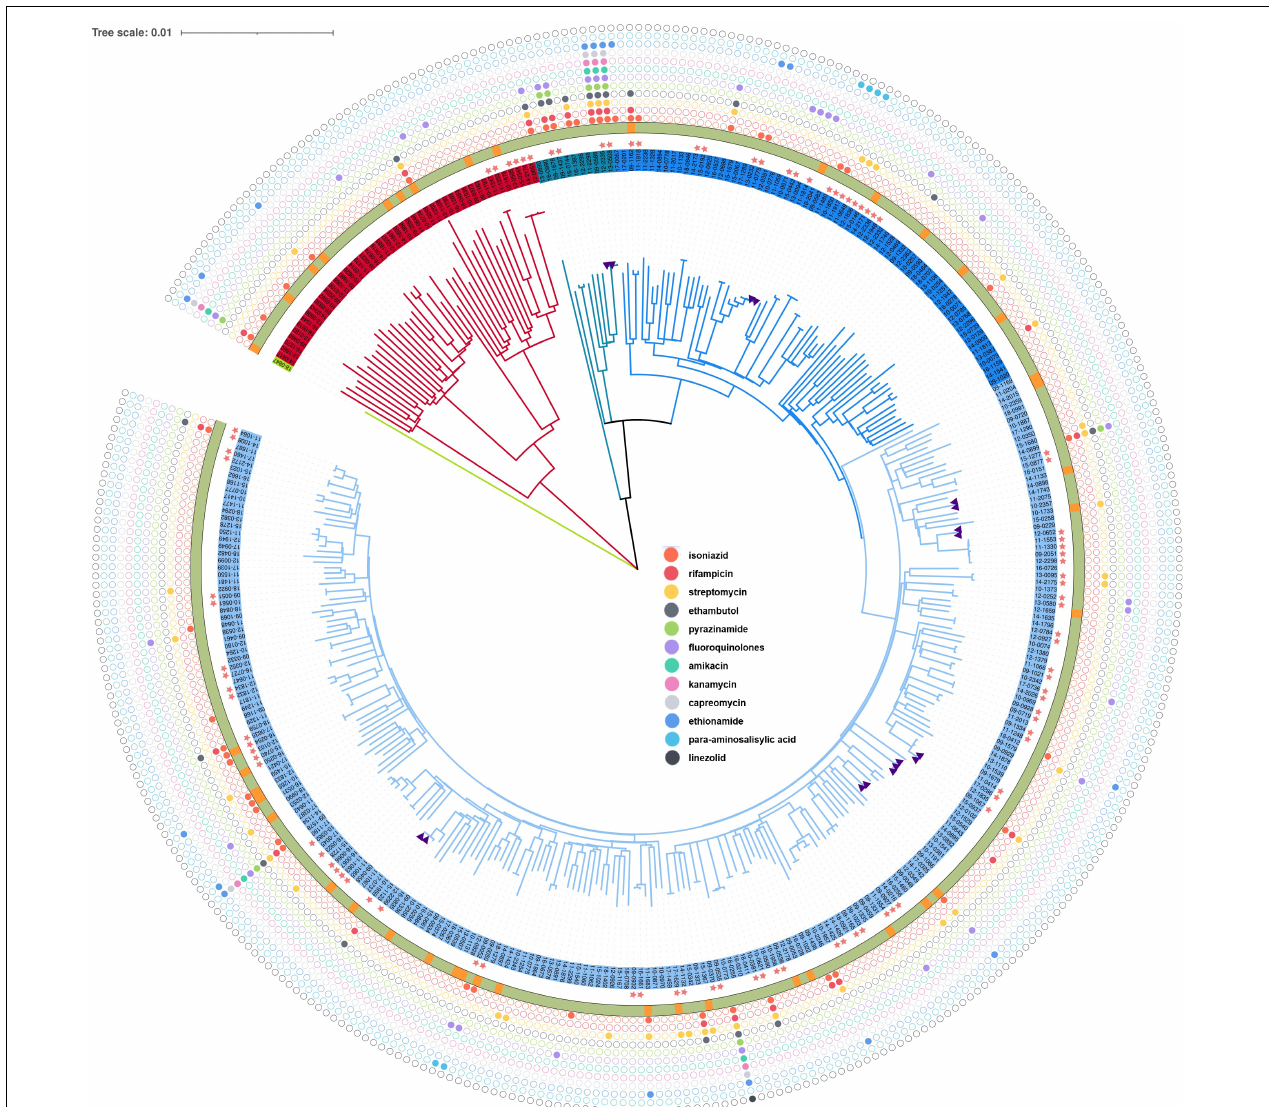
FIGURE 2 | Phylogenetic tree for the 354 Mycobacterium tuberculosis isolates from Shanghai, China, 2009–2018. The purple triangles represent isolates from relapsed cases ( n = 9). The pink five-pointed stars indicate the clustered isolates, whose genetic distance is ≤ 12 single-nucleotide polymorphisms (SNPs). The outer ring shows the census register of patients, of which the green represents resident and the orange represents migrant. From inside to outside, the solid colorful circles represent drug resistance mutations for isoniazid, rifampicin, streptomycin, pyrazinamide, amikacin, kanamycin, capreomycin, ethionamide, para -aminosalicylic acid, and